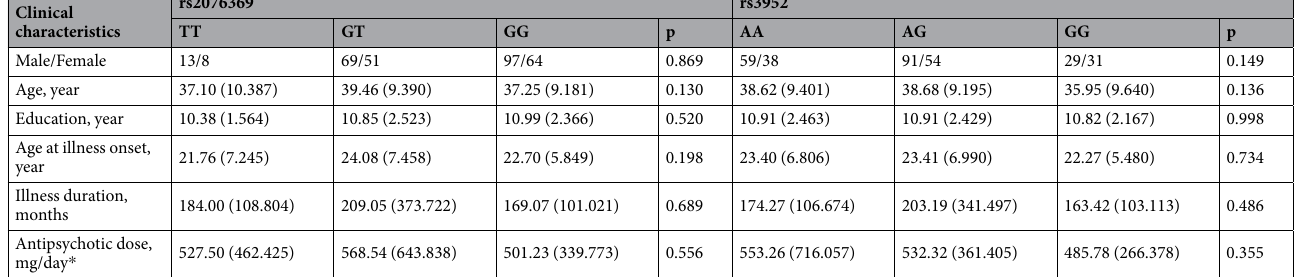
Table 1. Demographics of schizophrenic patients with different genotypes of PICK1. All data were presented by mean (standard deviation). Chi-Square test for categorical variables (gender); according to normality of data, Kruskal-Wallis test for continuous variables (except age which was normal distribution, so we used ANOVA test). * Antipsychotic dose, presented by chlopromazine equivalent